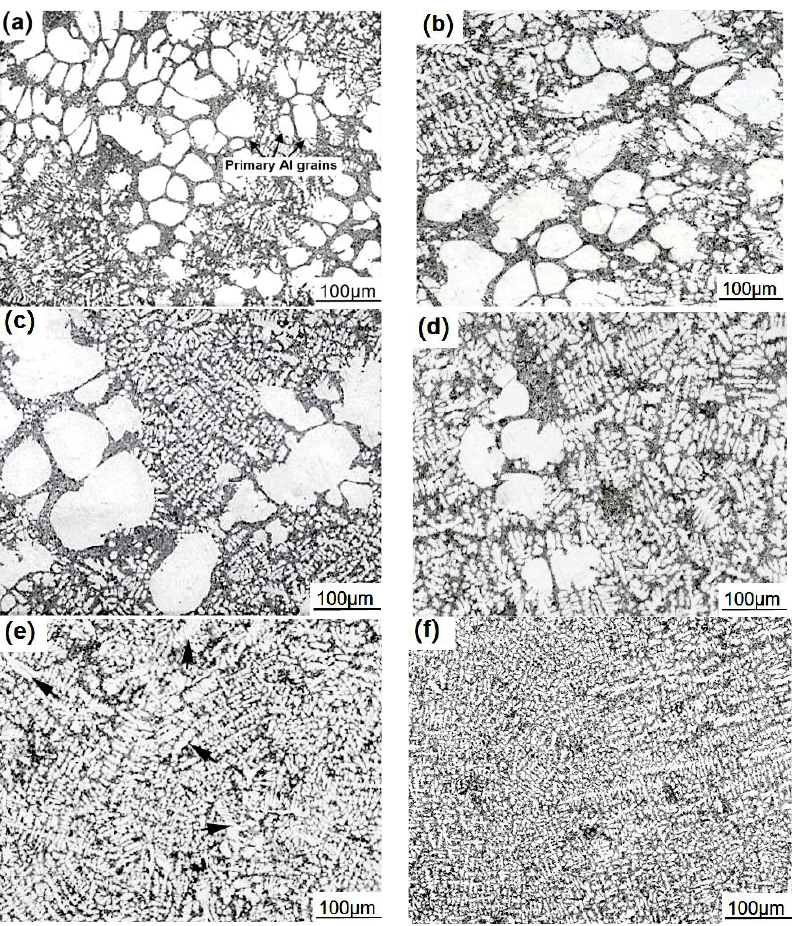
Figure 12. Microstructures of the water-quenched mixture after standing for ( a ) 0 s, ( b ) 5 s, ( c ) 10 s, ( d ) 30 s, ( e ) 60 s and ( f ) 10 min.